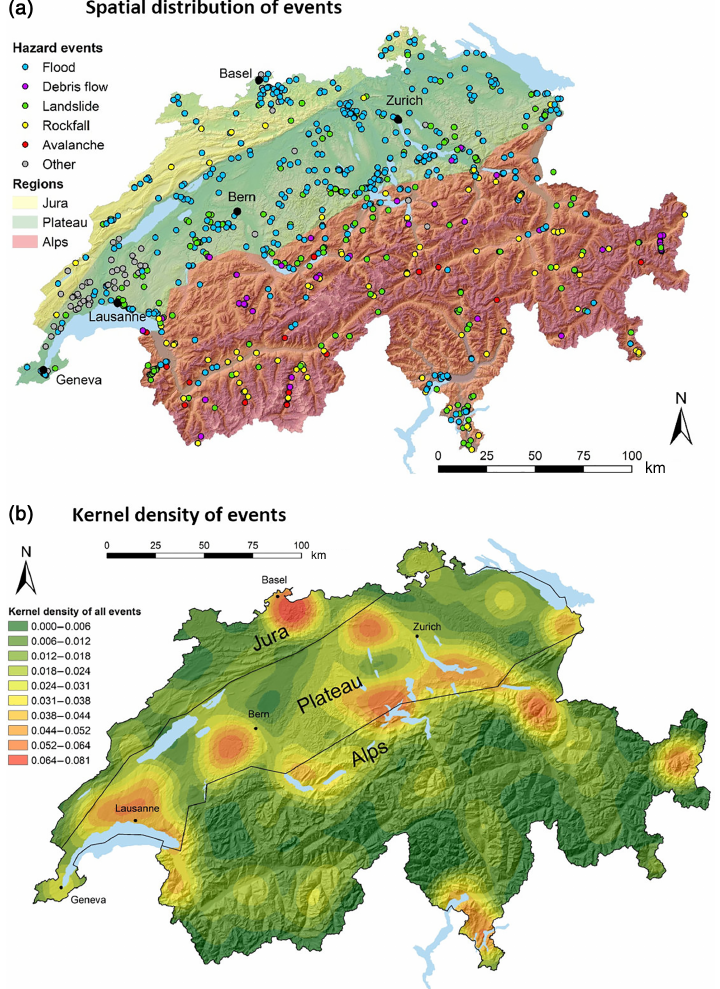
Figure 2. (a) Spatial distribution of natural hazard events affecting roads and railways in Switzerland from 2012 to 2016. Map source: Swisstopo. (b) Kernel density of the events (20 km search radius and results classified using 10 classes with the Jenks natural breaks method) based on ArcGIS